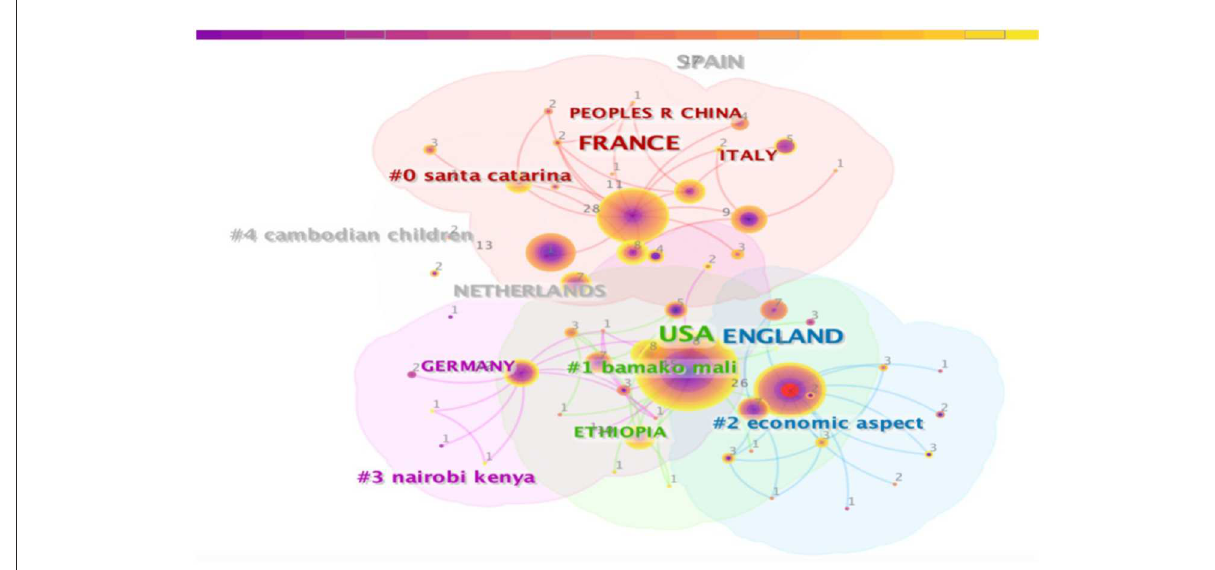
FIGURE4 Clustered network of co-country analysis on tuberculosis molecular epidemiology.